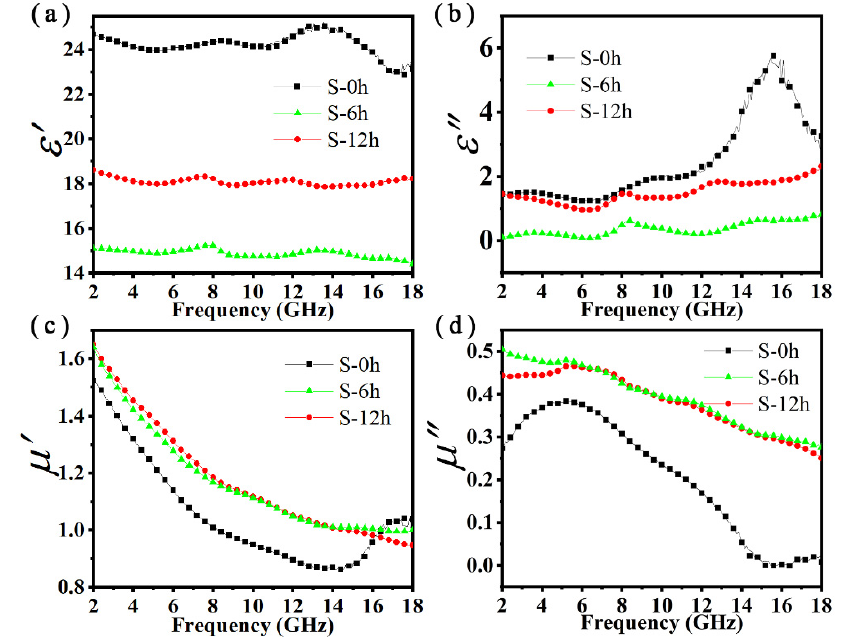
Figure 3. Electromagnetic performance for three samples of NiCoMnSn alloy flakes: ( a ) ε ’ − f , ( b ) ε ” − f , ( c ) μ ’ − f , and ( d ) μ ” − f .